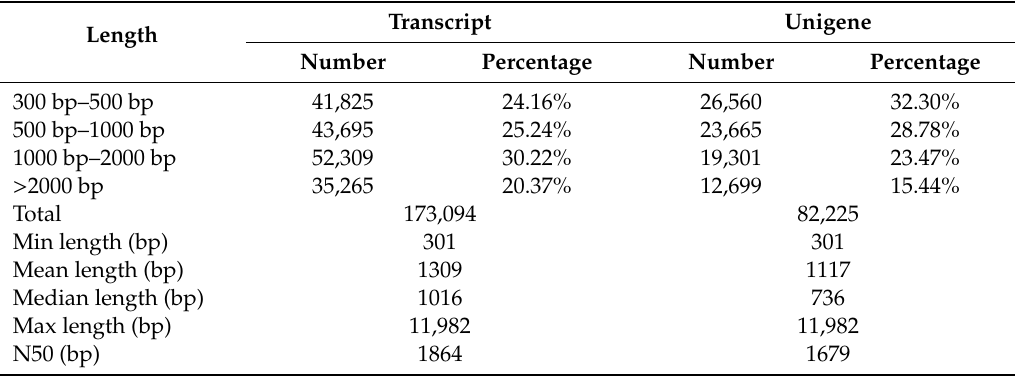
Table 2. Summary of Illumina transcriptome assembly for